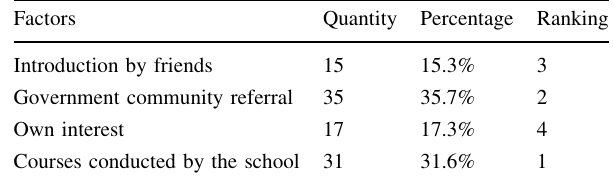
Table 1 Inducing factors for participation in martial arts fitness Factors